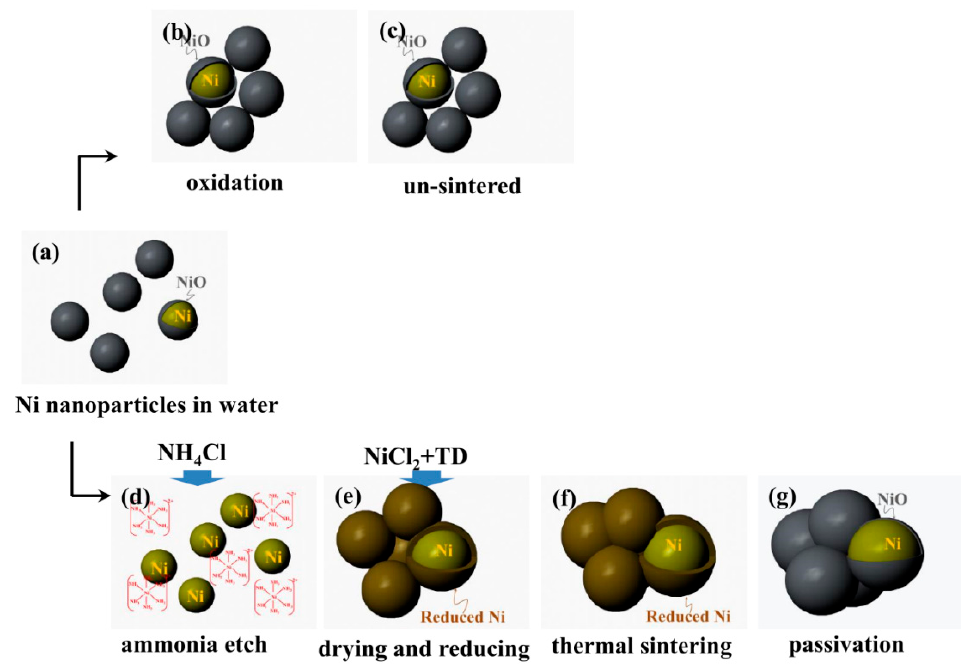
Figure 2. Schematics of printed patterns made by chemical process: ( a )–( b ): simply disperse nickel nanoparticle in water increase the oxidation which prevents nickel being sintered; ( d ) NH4Cl is added into the water to etch away the oxidation; ( e ) TD reductant more Ni 2+ are added into the water; ( f ) Ni 2+ ions are reduced and stick on the original nickel nanoparticles; ( g ) passivation layer reformation.